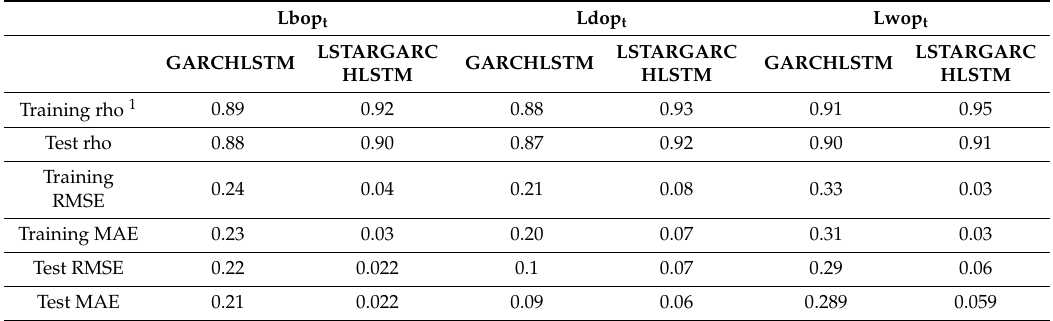
Table 6. Generalised Autoregressive Conditional Heteroskedasticity long-short term memory